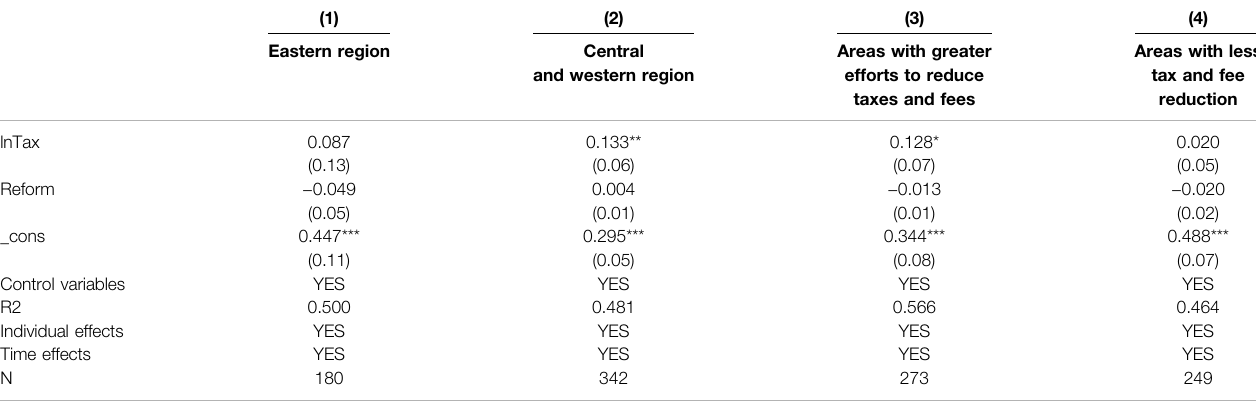
TABLE 9 | The test results of